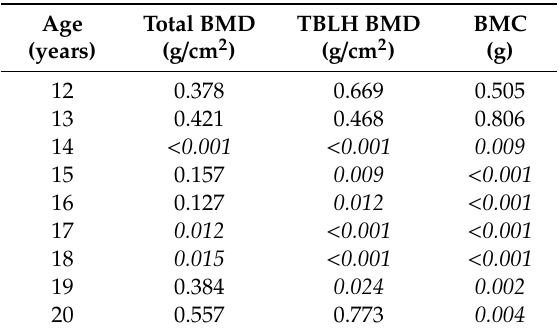
Table 3. Significance levels for sex di ff erences in BMD and bone mineral content (BMC) parameters among athletes (significant values in italics).